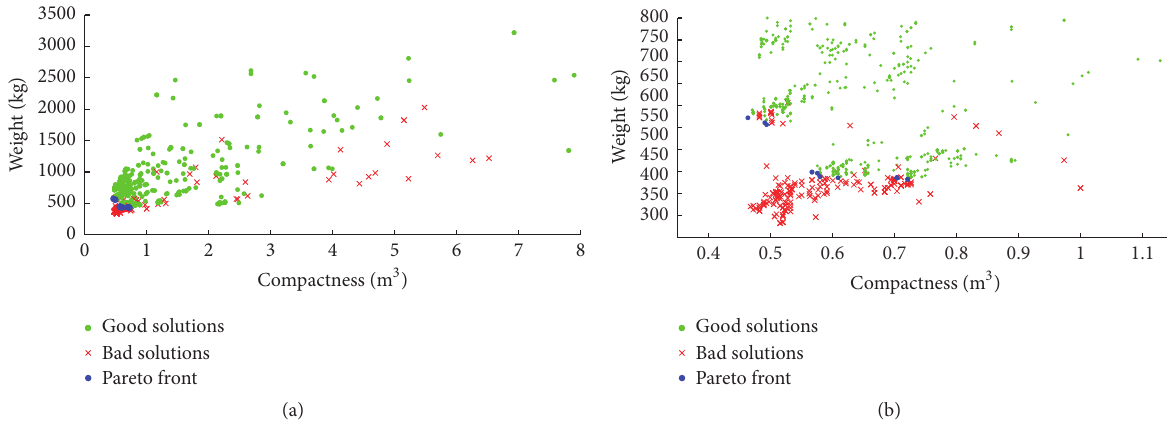
Figure 6: (a) The objective space for 60 individuals and 20 generations and (b) zoom on the Pareto front. The red crosses above the Pareto front have a low number of scissor units, which is the reason why they fail.